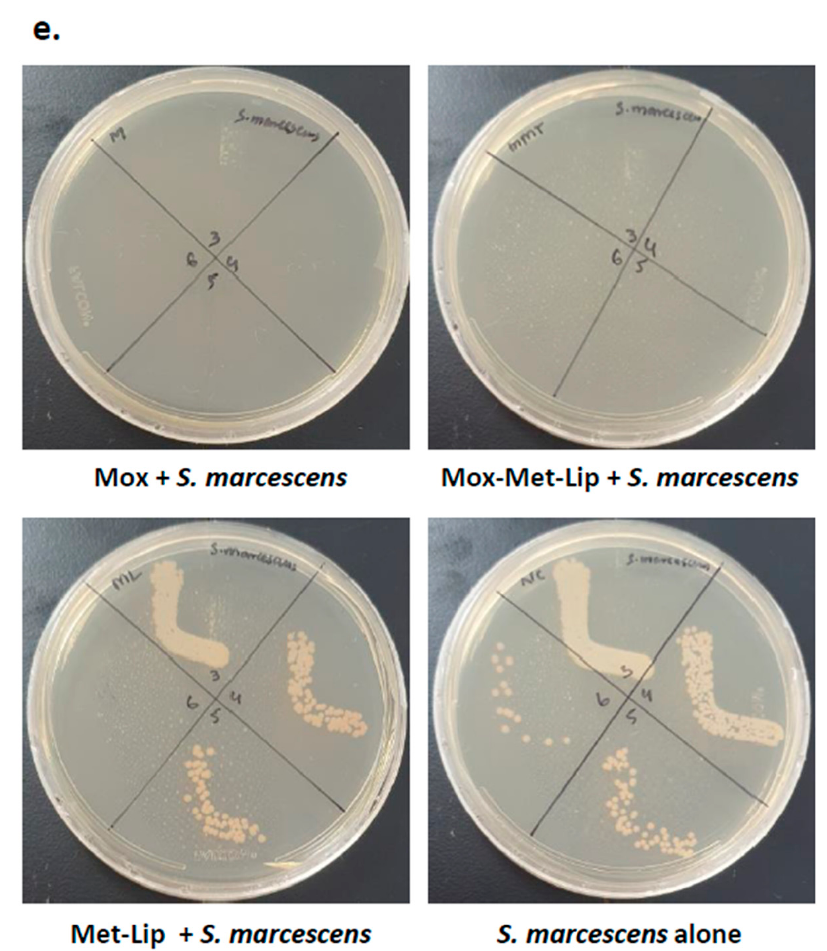
Figure 6. Drugs and their nanocarrier counterparts abolished Gram-negative bacteria. Briefly, bac- teria (1 × 10 6 ) were challenged with drugs and drug-loaded formulations for 2 h at 37 ◦ C. Drugs and drug-loaded nanocarriers showed excellent antibacterial effects against Gram-negative bacteria. ( a ) When tested against P. aeruginosa , ( b ) against S. marcescens , ( c ) K. pneumoniae, ( d ) S. enterica and ( e ) illustrative effects of S. marcescens. Where MeOH represents methanol, Mox represents Moxi- floxacin, MML stands for Moxifloxacin-loaded metronidazole liposomes, Sulp stands for Sulfamethax- azole, SML represents Sulfamethaxazole-loaded metronidazole liposomes, Met-Lip indicates metron- idazole liposomes, and Gent represents Gentamicin. The data are expressed as the mean ± standard error, where (*) represents when p ≤ 0.05.